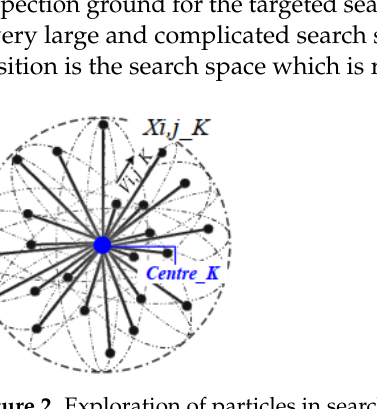
Figure 2. Exploration of particles in search space along the radii. Where the 𝑛𝑜𝑝 and 𝑛𝑜𝑑 denote the number of particles in the design and the num- ber of dimensions, which depends on the number of variables needed to be optimized, respectively. The particle positions are calculated using Equation (4), where the 𝑛𝑜𝑝 and 𝑛𝑜𝑑 remain constant.